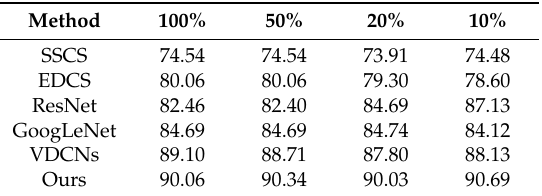
Table 6. Comparison of classification rates on Dataset 2 under different resolutions.